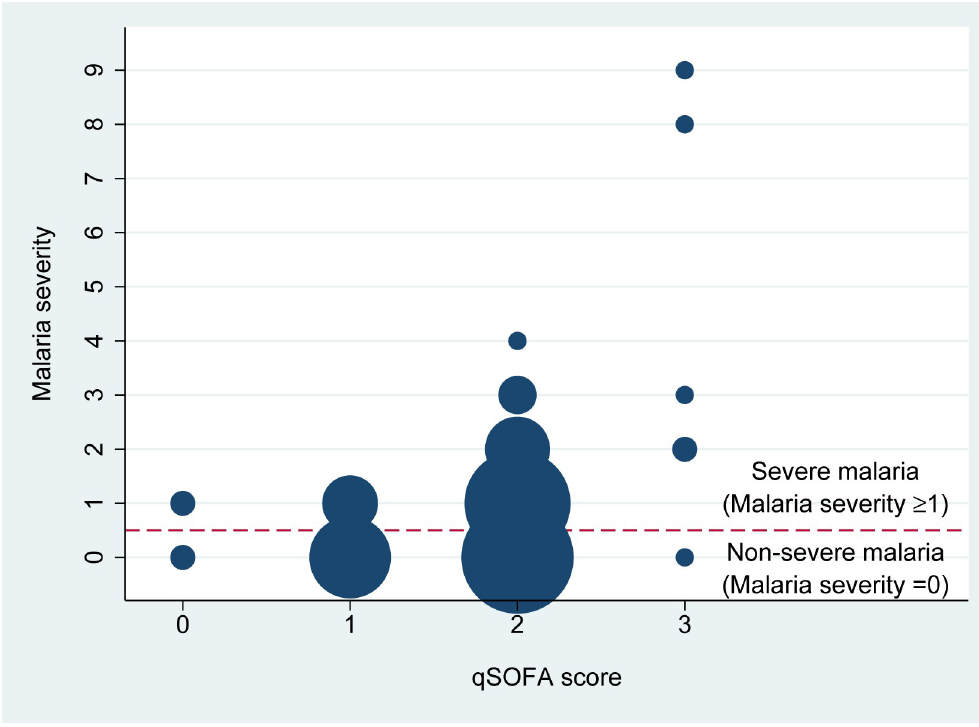
Fig 1. Relationship between qSOFA score and malaria severity (the total number of WHO severity criteria for severe malaria satisfied by the patient). Size of each dot represents the total number of patients with a qSOFA score and malaria severity. Each smallest dot represents one patient, and the biggest dot represents 45 patients (qSOFA score of 2 and malaria severity of 0). Both fatal patients in the study had malaria severity of �